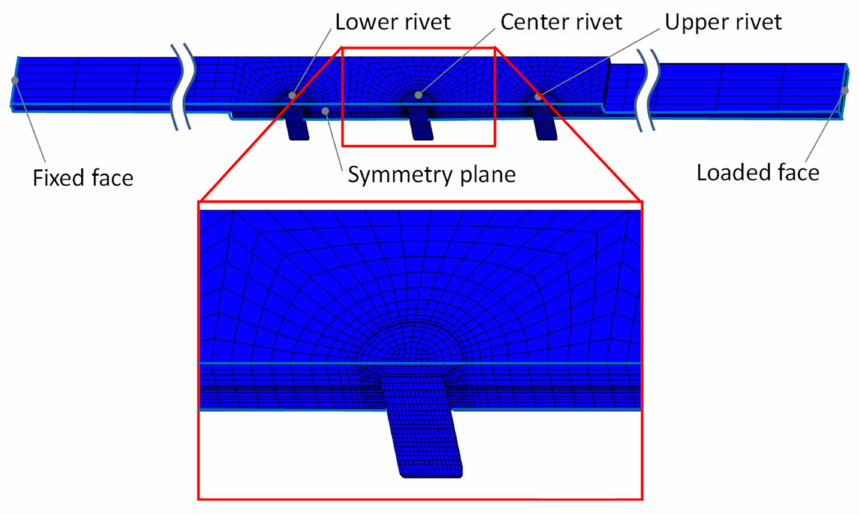
Figure 14. Detailed model of triple-row joint for the finite element analyses.